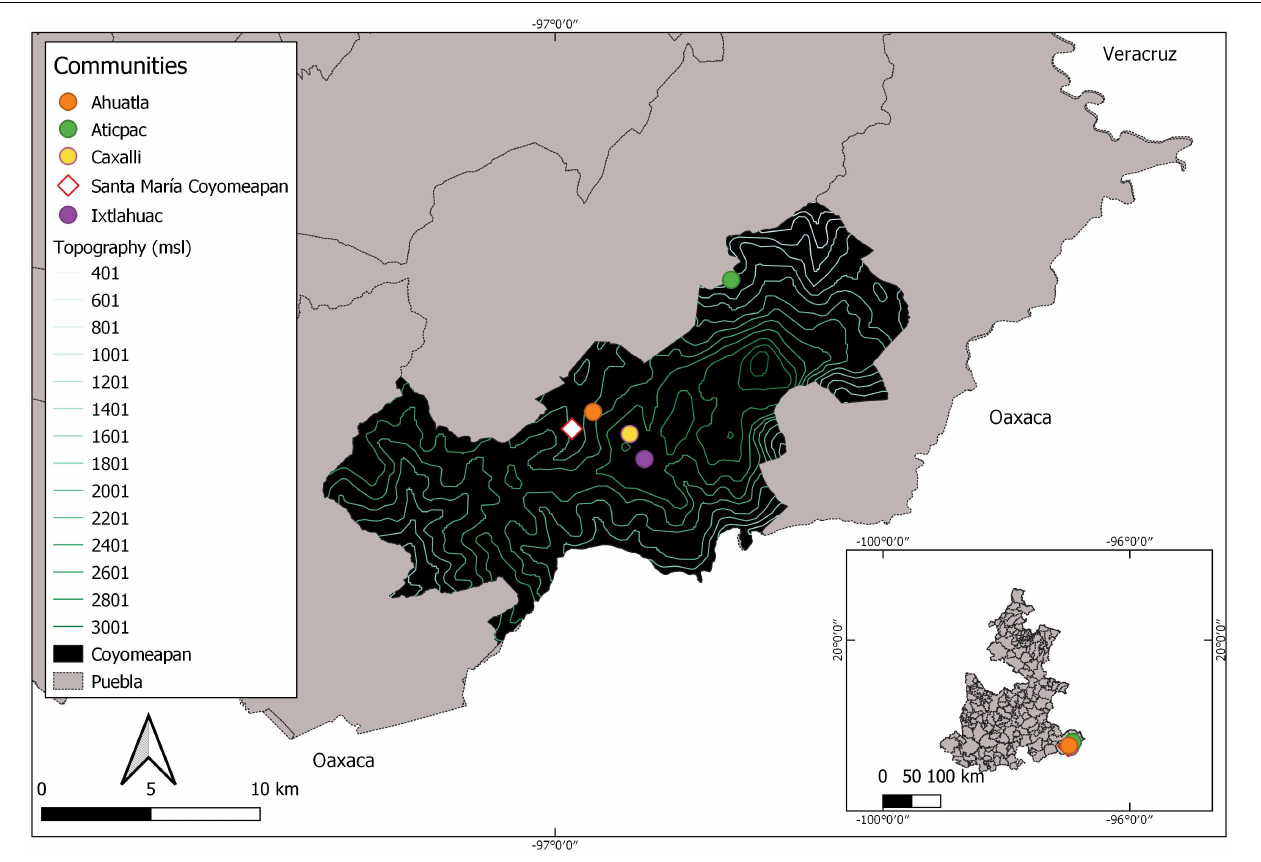
FIGURE 1 | Study Area. Rural communities are displayed as circles and the municipal seat as a square. Aticpac is classified as “Tierra Caliente” (TC) while Ahuatla, Caxalli, and Ixtláhuac as “Sierra.” The Cerro del Tzintzintepetl (Tzintzintepetl Hill) is located in the highest elevation area between Aticpac and the Sierra communities. Figure elaborated in Quantum Geographic Information System (QGIS) (Open Source Geospatial foundation [OsGeo], 2020). with layers available from Geoportal Comisión Nacional para la Biodiversidad (CONABIO, 1998; Ávila-Blomberg and Moreno-Díaz, 2008; Instituto Nacional de Estadística, Geografía e Informática [INEGI],